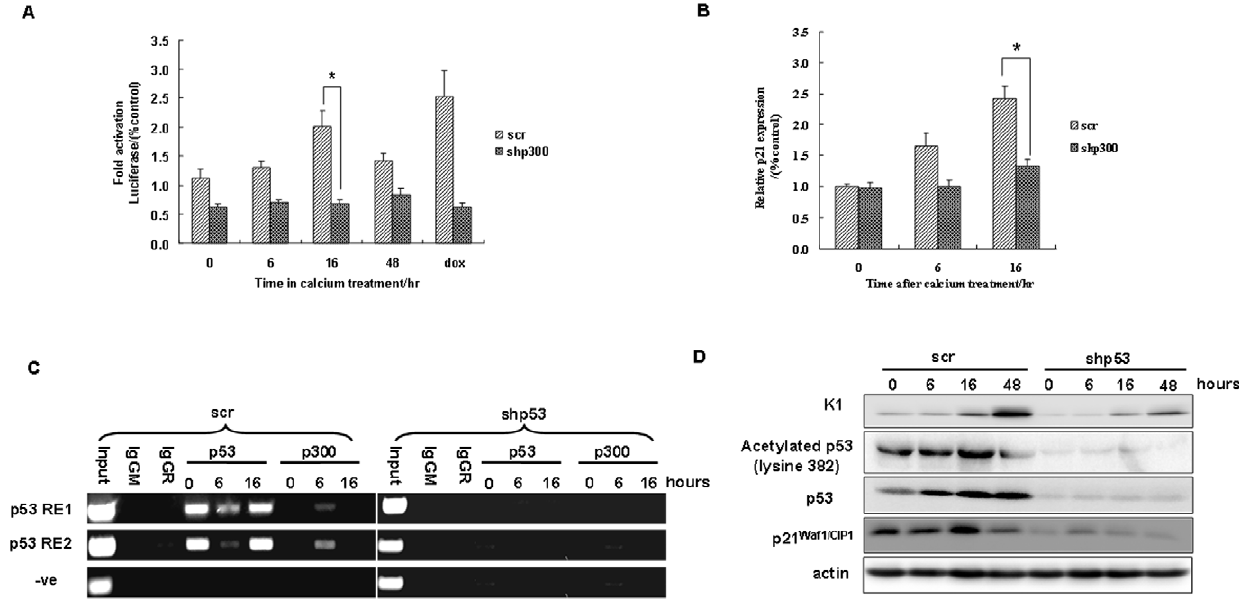
Figure 4. p300 regulates p21 Waf1/CIP1 expression at transcriptional level. Stably expressing p300 targeted shRNAs cells were transfected with p21 Waf1/CIP1 promoter luciferase construct. Transfected cells were either kept in low calcium (0.5 mM) or high calcium (1.5 mM) for the